Question: What type of chart is this?
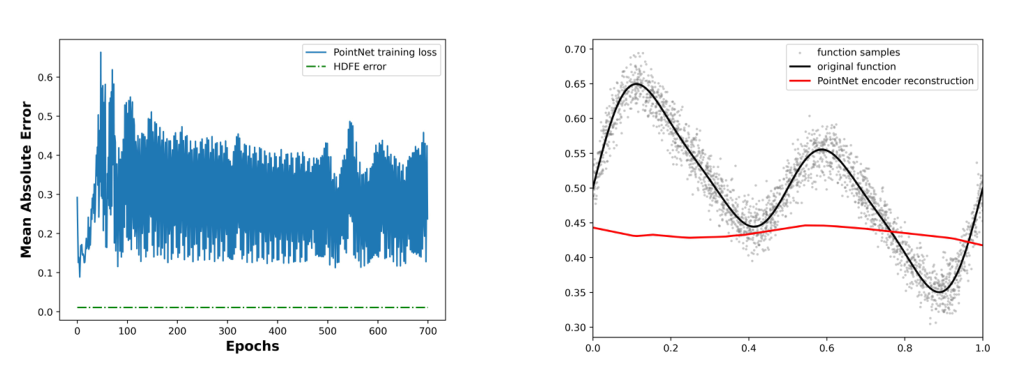
Answer: line